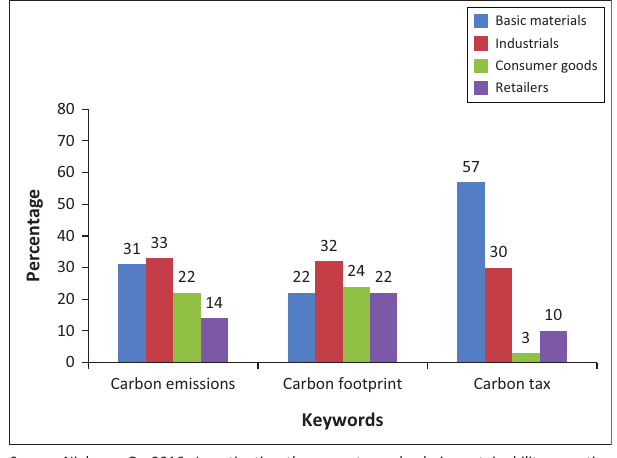
FIGURE 3: Sector contribution to carbon emissions, carbon footprint and carbon tax.